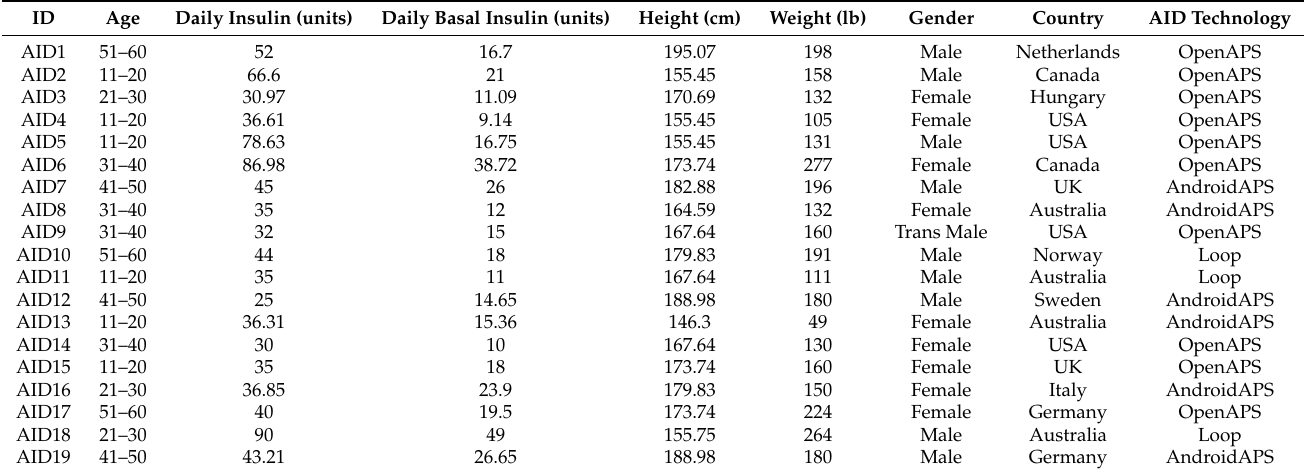
Table 2. Self-reported demographics of selected AID users within OpenAPS Data